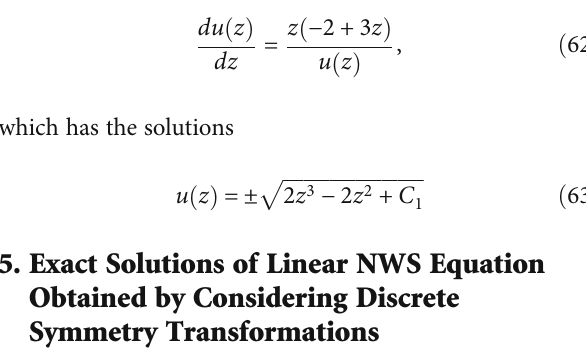
Figure 2: Exact sol. of (1) given by (41).